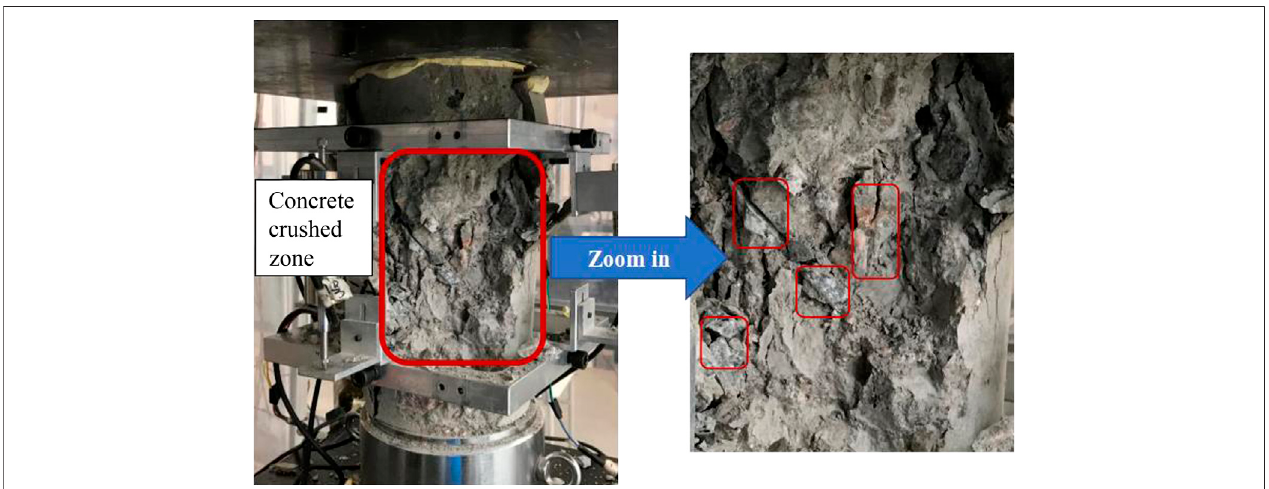
Figure 10 | Failure mode for uncon fi ned low-strength concrete.